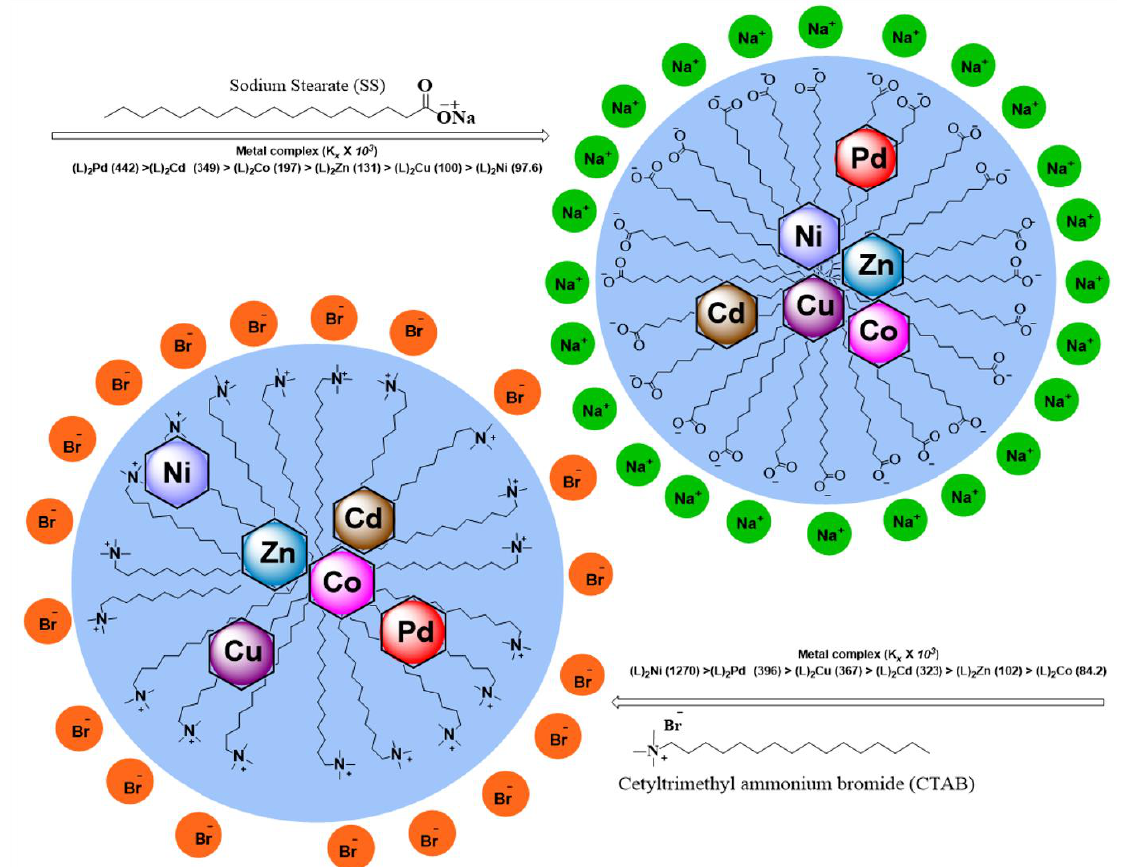
Figure 6. Partitioning behaviour of M(II) complexes in the micelles of SS and